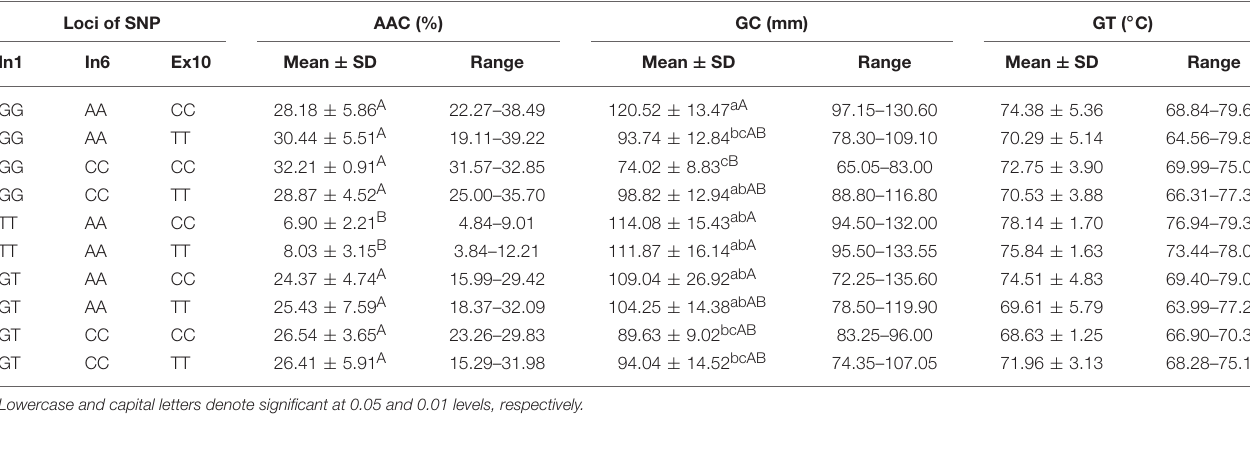
Frontiers in Plant Science |